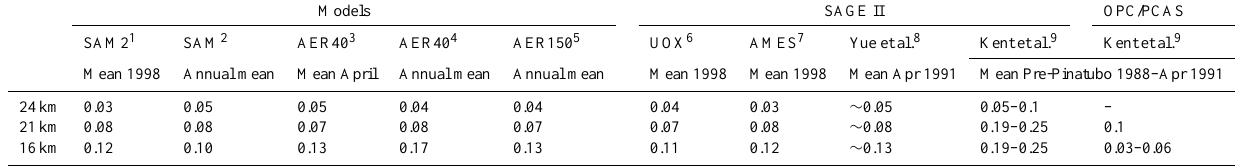
Table 3. Stratospheric aerosol mass densities in (µgm − 3 ) at 40 ◦ N and three altitudes, derived from different models and oberservations. Models